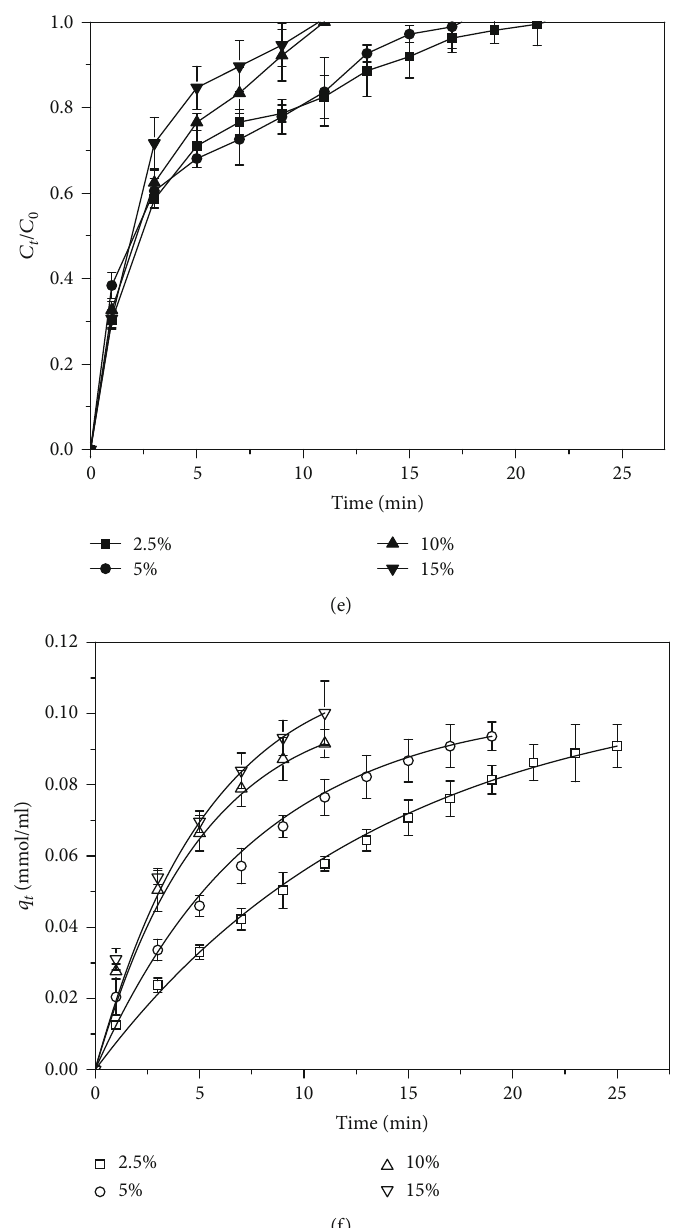
Figure 7: Breakthrough curves and CO capture of slurry of CPEI-1, CPEI-2, and CPEI-3 (a, b), at di ff erent temperatures using CPEI-3 (c, d), 2 various mol % of CO /N mixture (e, f) using CPEI-3, under 2 2